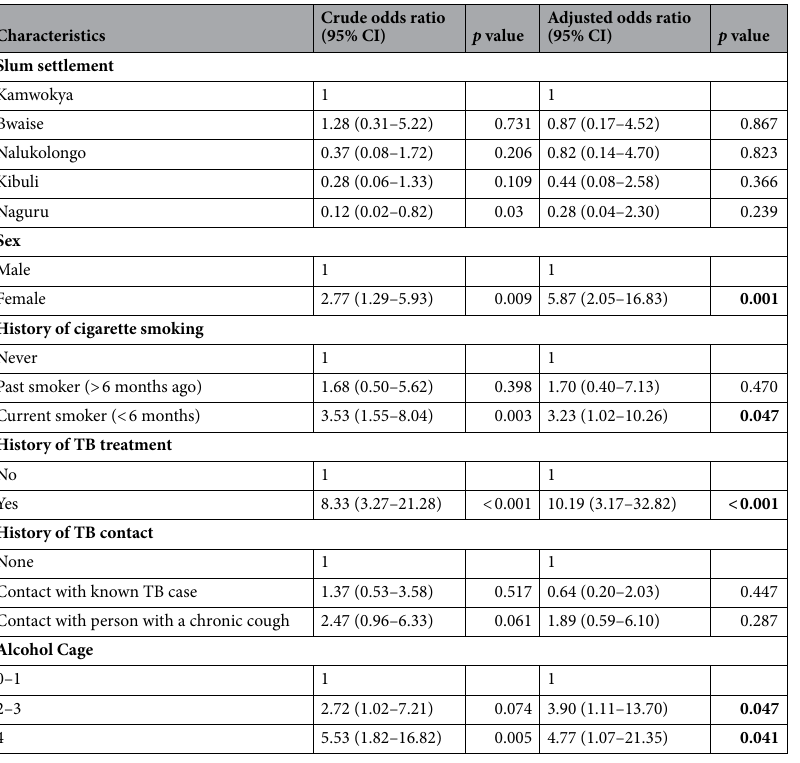
Table 3. Multivariable logistic regression model for predictors of HIV infection among individuals found at bars in slums of Kampala.